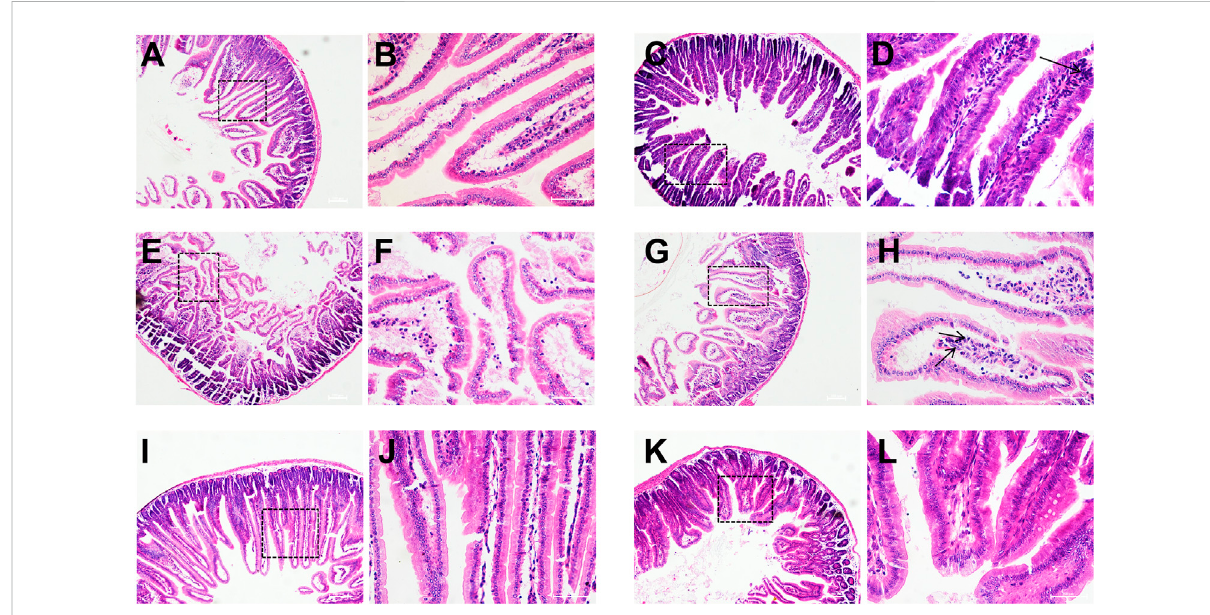
FIGURE 8 Histopathological observation of mice duodenum. Control group (A , B) , model group (C , D) , O101/ Δ luxS::Apr model group (E , F) , 1,8-cineole low-dose group (G , H) (0.3 g/kg), medium-dose group (I , J) (0.6 g/kg) and high-dose group (K , L) (1.2 g/kg). (A , C , E , G , I , K) , HE, 100×; (B , D , F , H , J , L) , HE,